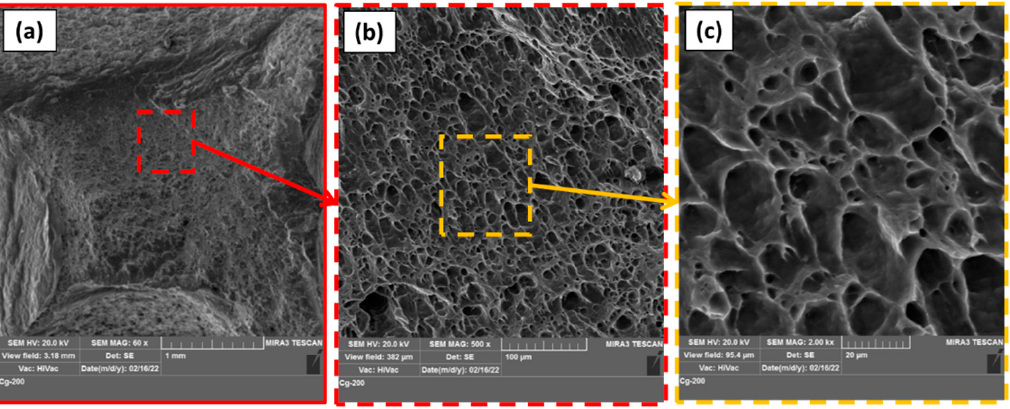
Figure 21. SEM images of the fracture surfaces of the failed specimens after tensile testing for AA1050 BM ( a ) and the processed materials using different pin geometries at the processing param- eters of 600 rpm rotation speed and travel speeds of 50 mm/min ( b , d , f ) and 300 mm/min ( c , e , g ).